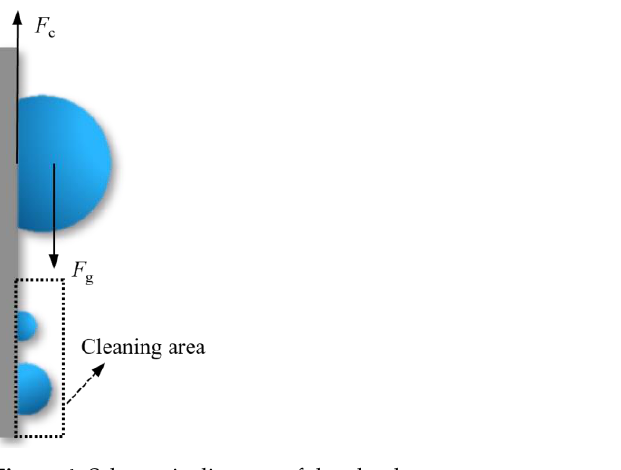
Figure 4. Schematic diagram of droplet departure.